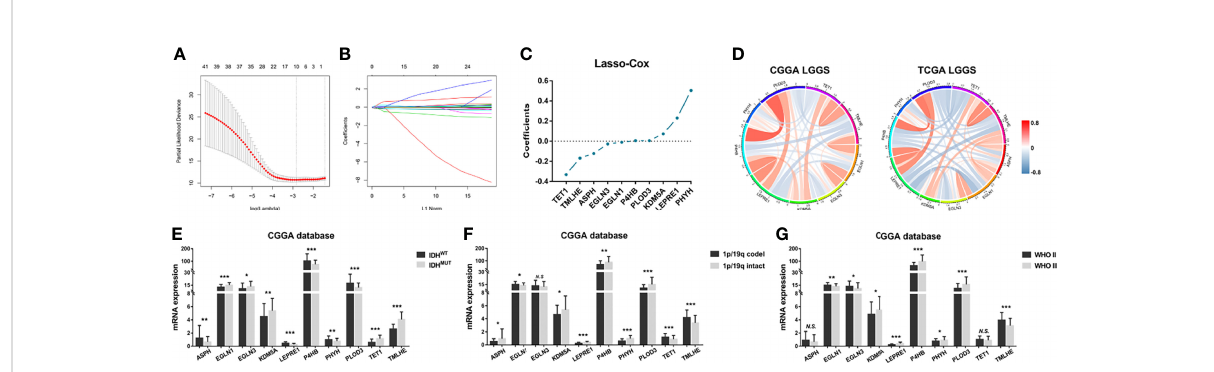
FIGURE 2 Construction of enzyme-based prognostic signature. (A, B) The 10-fold cross-validation for Lasso Cox analysis identi fi ed 10 genes with a non- zero coef fi cient. (C) The genes with non-zero coef fi cients in Lasso were plotted. (D) These 10 genes showed similar relationship in both CGGA and TCGA datasets. (E) The expression patterns of these genes were compared between IDH MUT and IDH WT groups, (F, G) 1p/19q intact and codeletion groups, as well as WHO II and WHO III groups. * p < 0.05, ** p < 0.01, and *** p < 0.001. Lasso, least absolute shrinkage and selection operator; CGGA, Chinese Glioma Genome Atlas; TCGA, The Cancer Genome Atlas; NS, No Signi fi